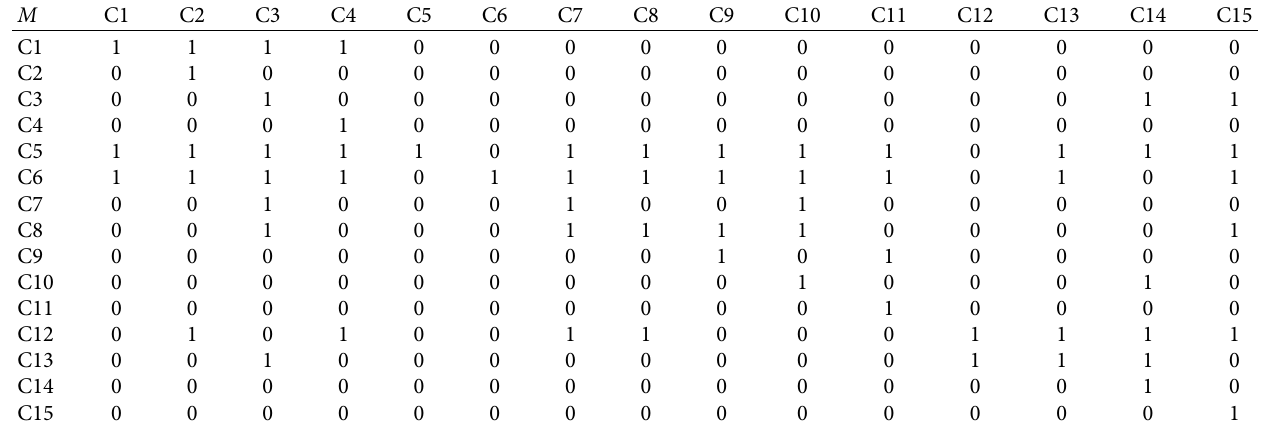
Table 7: Reachable matrix.